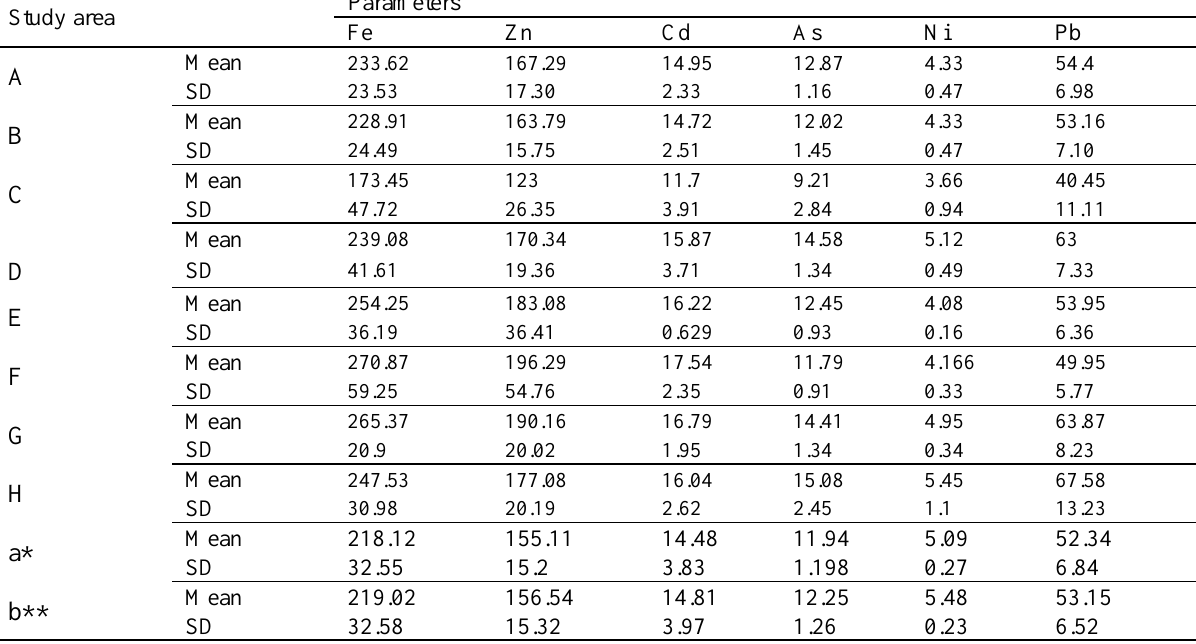
Table 10. Mean changes in concentrations of heavy metals in Tizro Grease Oil re-refining plant of Garmsar (ng/m 3 ) Study